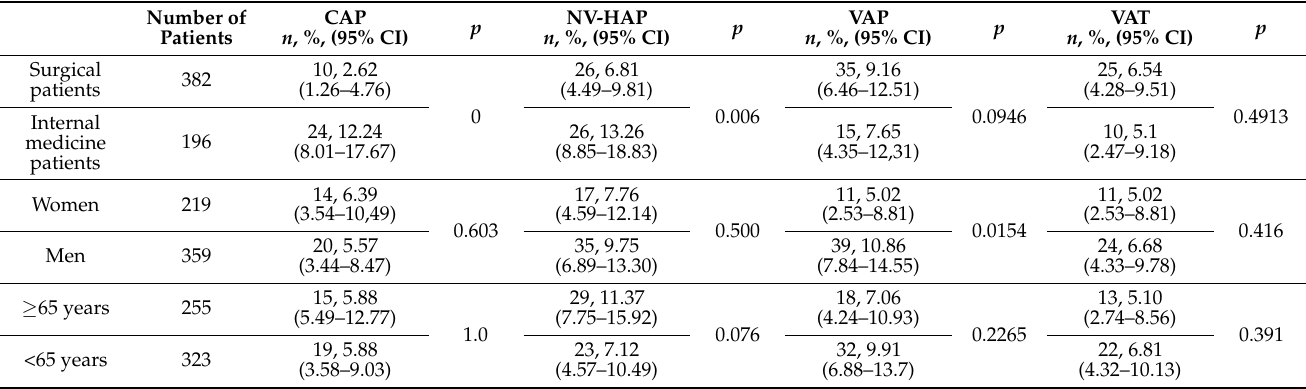
Table 3. Rate of RTIs in terms of gender, age, reasons for hospitalization. Data are presented as number, %, 95% CI.